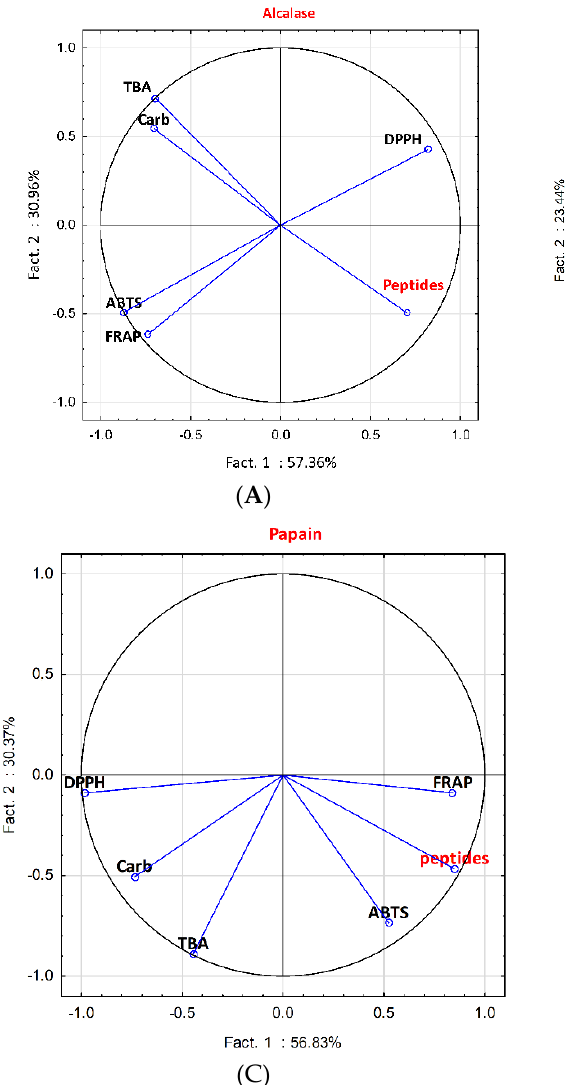
Figure 8. PCA loading plot of antioxidants activity and peptides concentration for alcalase ( A ), collagenase ( B ) and papain ( C ).